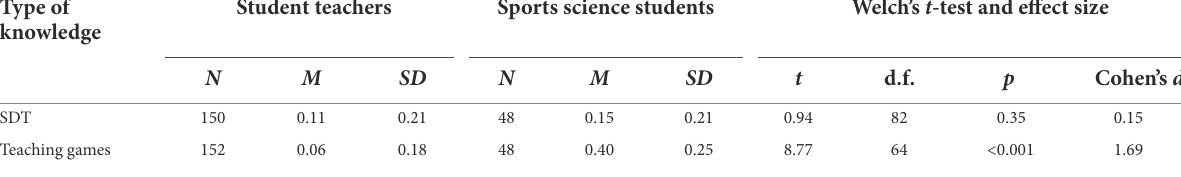
TABLE 1 Self-reported knowledge of self-determination theory (SDT) and teaching games in physical education. Type of knowledge